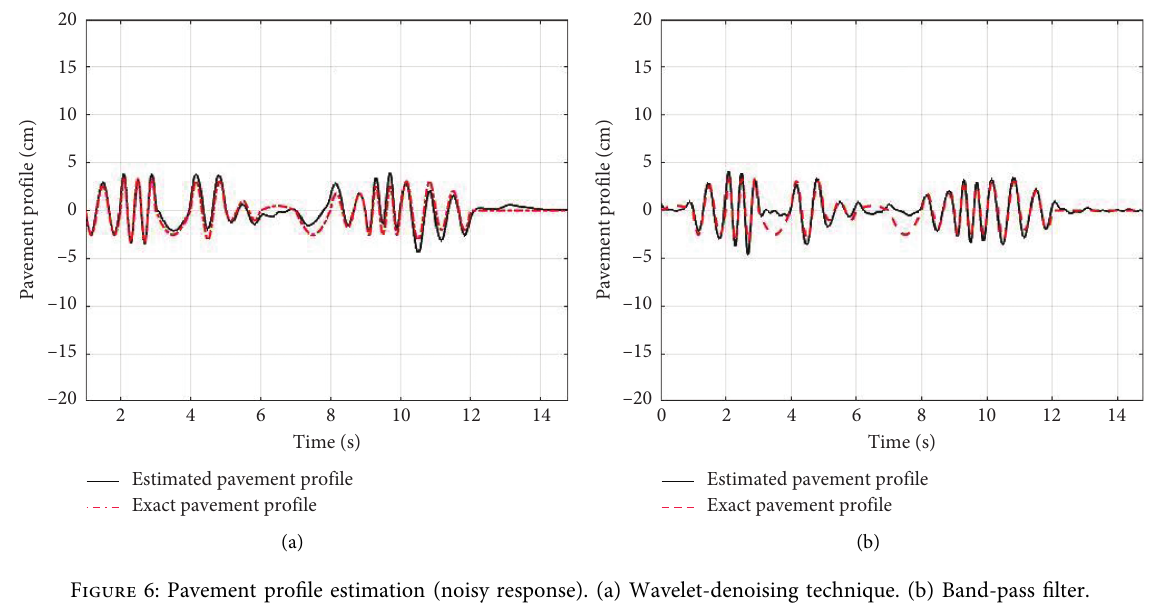
Figure 6: Pavement profile estimation (noisy response). (a) Wavelet-denoising technique. (b) Band-pass filter.